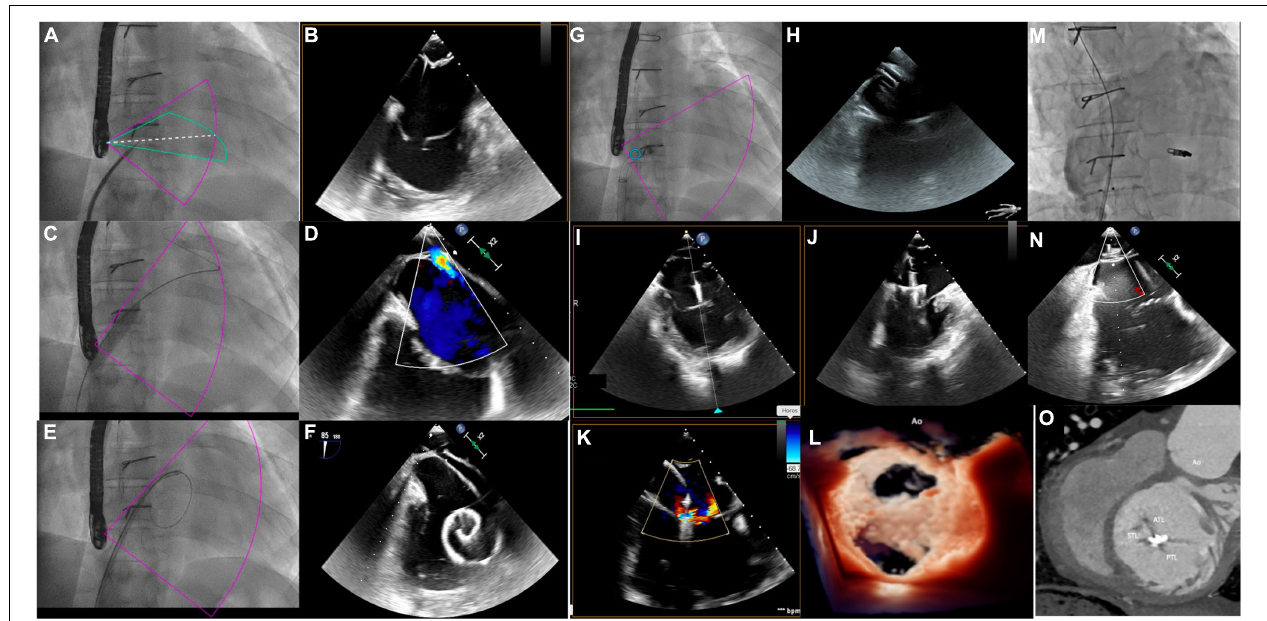
FIGURE 4 | MitraClip implantation for systemic tricuspid valve regurgitation. (A,B) Catheter and needle are positioned at the level of the anterior part of the intra-atrial inferior vena cava channel under transesophageal echocardiography (TEE) guidance. The 80 ◦ TEE plane shows needle tenting and guarantees a distance of at least 40 mm between the tenting and the systemic atrio-ventricular valve (SAVV) and the alignment with the SAVV. (C) The balloon is inflated to enlarge the transbaffle access. (D) TEE shows the right to left shunt on color doppler after balloon inflation. (E,F) The guidewire is positioned in the systemic atrium to advance the MitraClip sheath. (G,H) MitraClip sheath is positioned on the systemic atrium at 40 mm or more from the SAVV. (I,J) The MitraClip system is advanced through the sheath and positioned on top of the jet origin, with the clip fully opened. Perpendicular orientation of the clip relative to the anteroseptal commissure is guided by the Xplane 3DTEE in the mid-esophagus position. (K) XTR MitraClip fully closed at the level of the anteroseptal commissure creates a double-orifice SAVV with two mild residual jets on color doppler. (L) Double-orifice SAVV on 3D Zoom true view mode after XTR clip insertion. (M) Inferior vena cava channel angiogram after placement of an 8 mm atrial septal defect (ASD) device to close the transbaffle access showing an absence of obstruction. (N) The 80 ◦ TEE view showing no residual shunt at the level of the ASD device. (O) Post- MitraClip computed tomography showing the position of the clip at the level of the anteroseptal